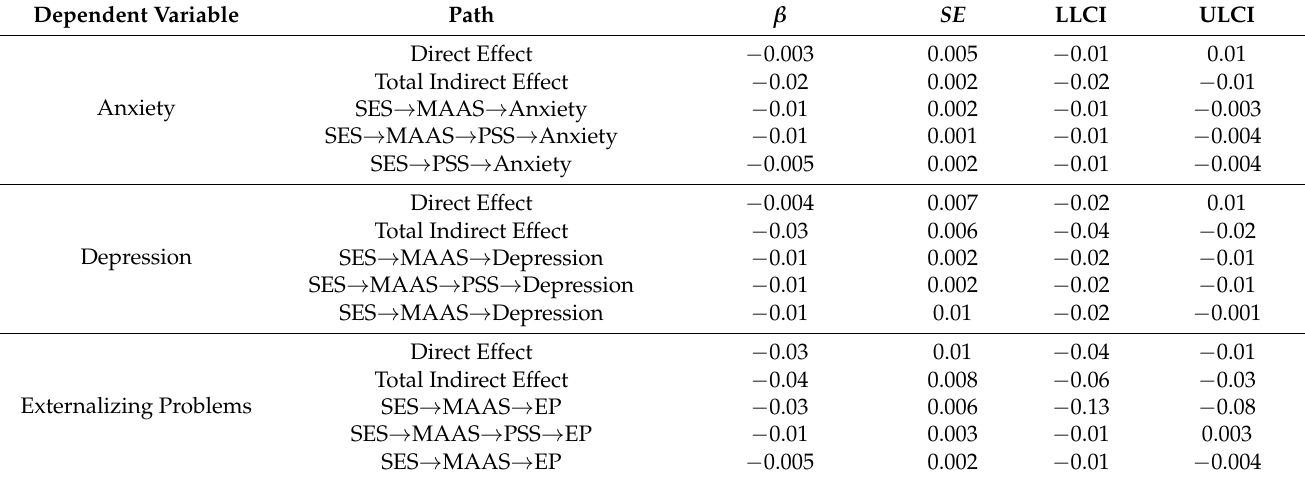
Figure 2. Serial Mediation Model of Socioeconomic to Internalizing Problems: Depression. ** p < 0.01. *** p < 0.001.